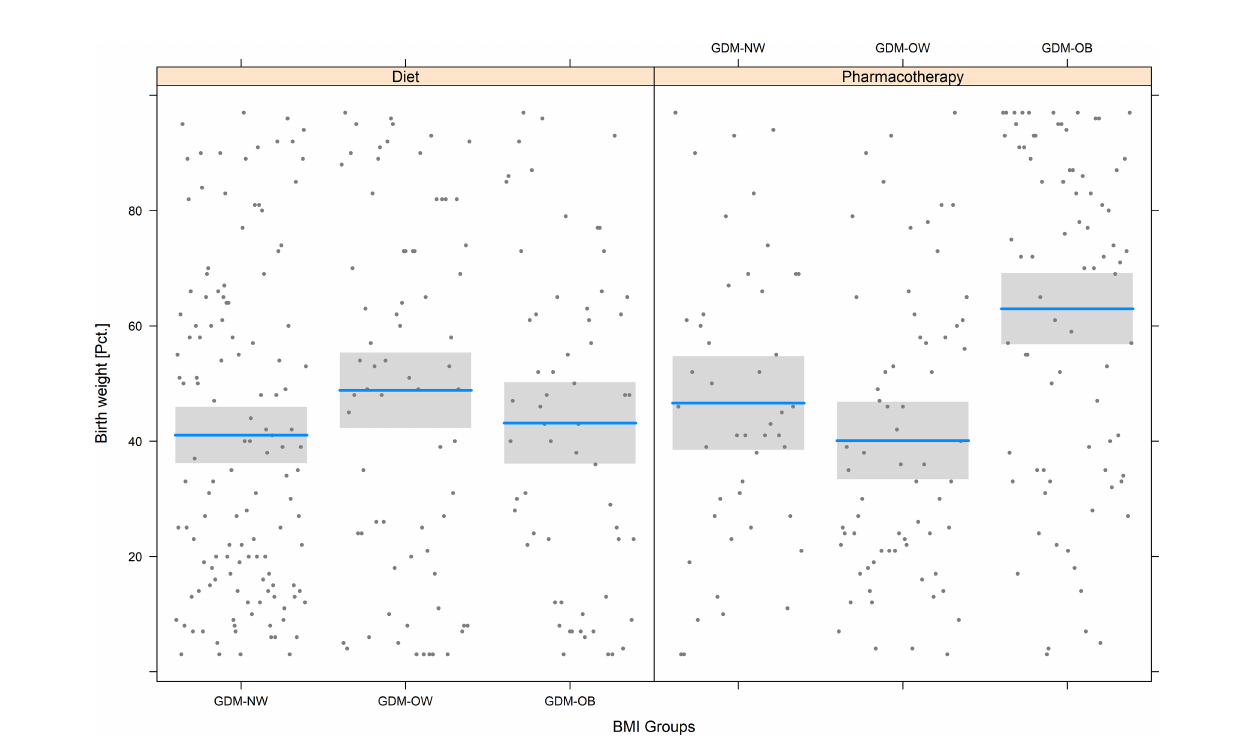
FIGURE 2 | Birth weight percentiles in normal weight (GDM-NW), overweight (GDM-OW) or obese patients with GDM (GDM-OB), categorized further into patients who received glucose lowering pharmacotherapy (PT) or diet only. The grey box represents the interquartile range. The median is indicated by a blue